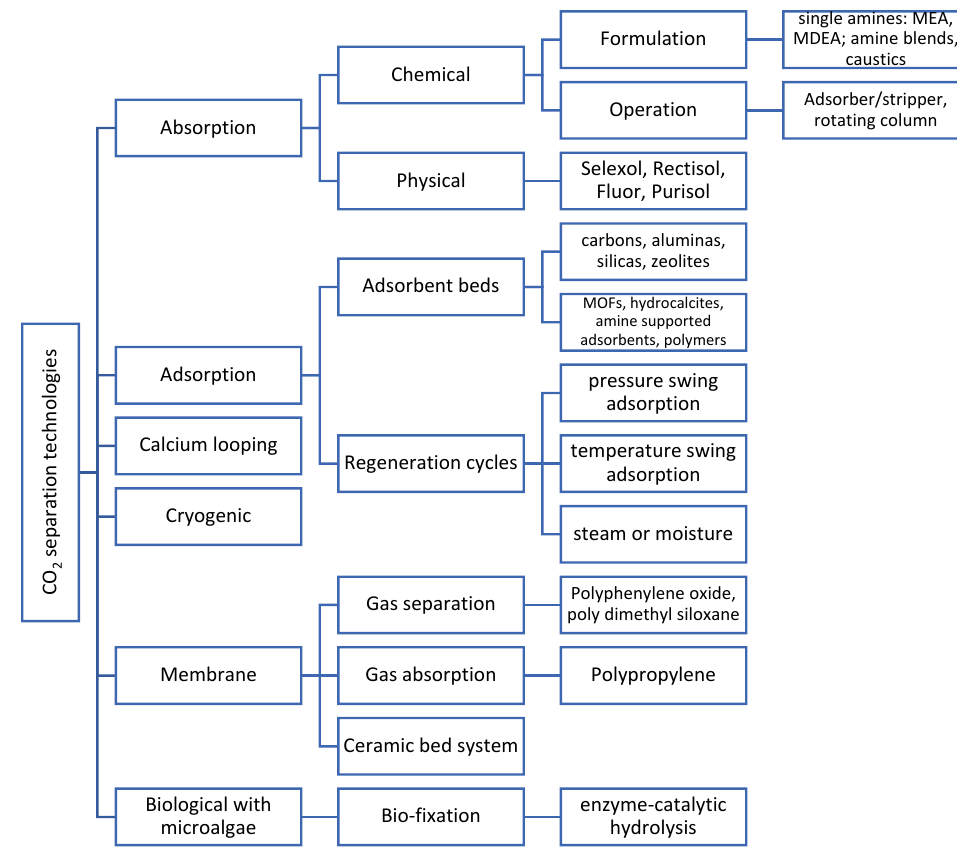
Figure 1. CO 2 separation technologies. Adaptation from Babar, Bustam, Ali, Shah Maulud, Shafiq, Mukhtar, Shah, Maqsood, Mellon and Shariff [7], Ben-Mansour, Habib, Bamidele, Basha, Qasem, Peedikakkal, Laoui and Ali [8].